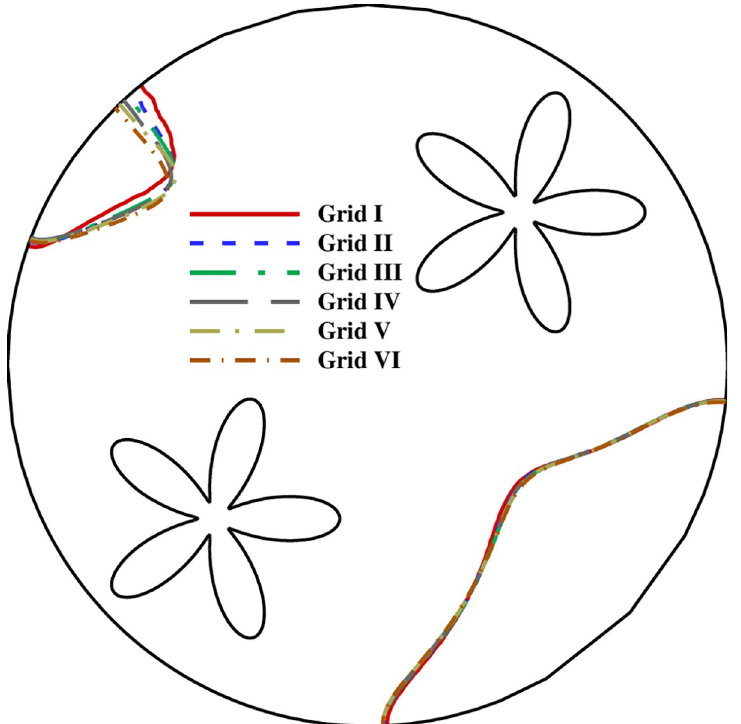
Fig 3. The influence of mesh size on the melting interface at t = 1750s (MVF = 0.75).